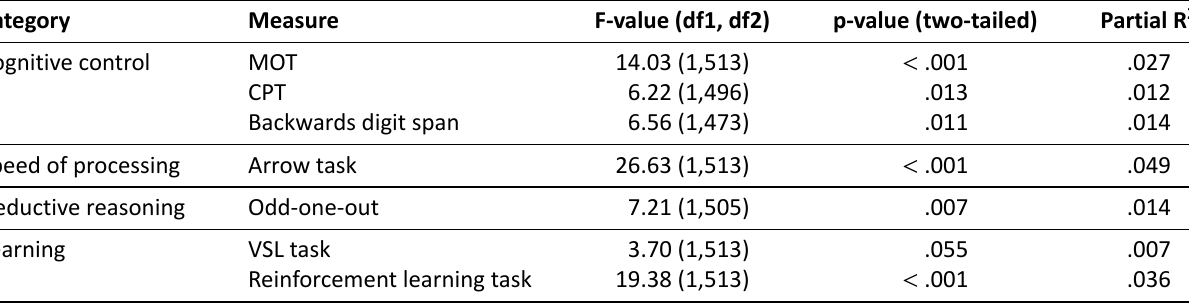
Table 2. Regression values between League of Legends MMR and cognitive